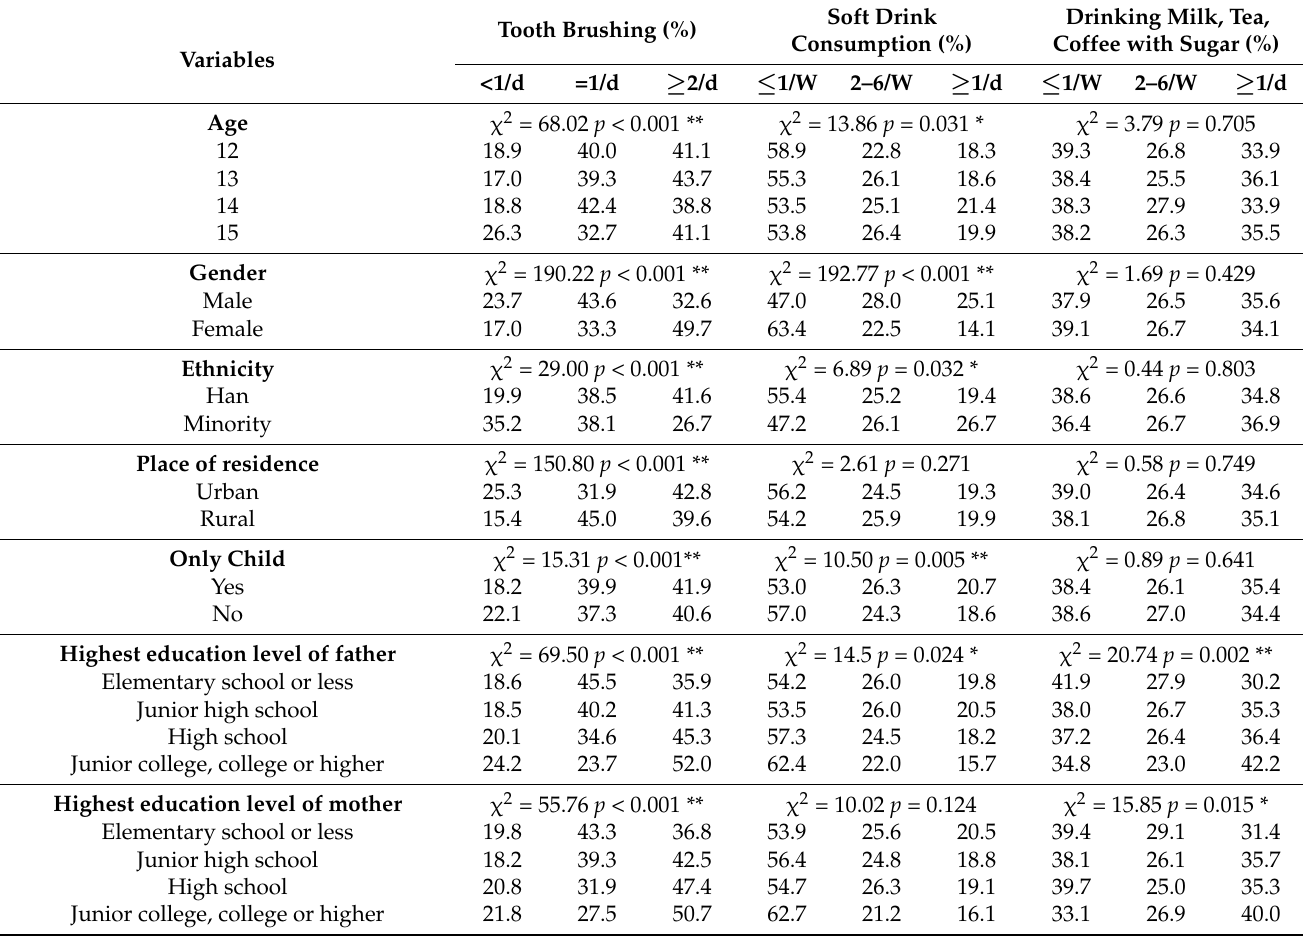
Demographics characteristics of participants by tooth brushing and